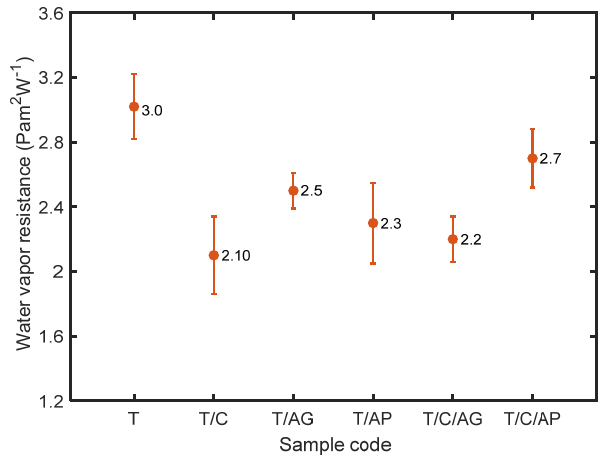
Figure 10. Water vapor resistance of the electro-sprayed materials.